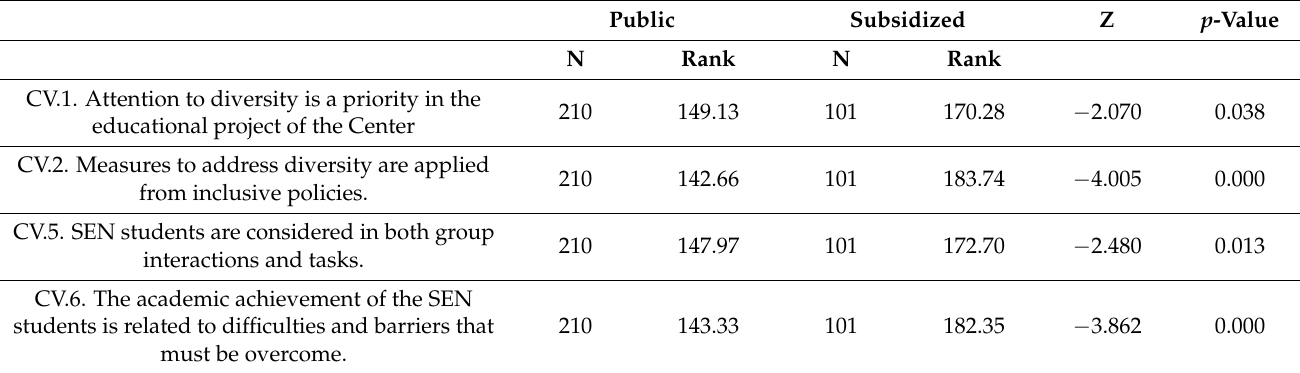
Table 9. Analysis of the Mann Whitney U according to the type of center’s